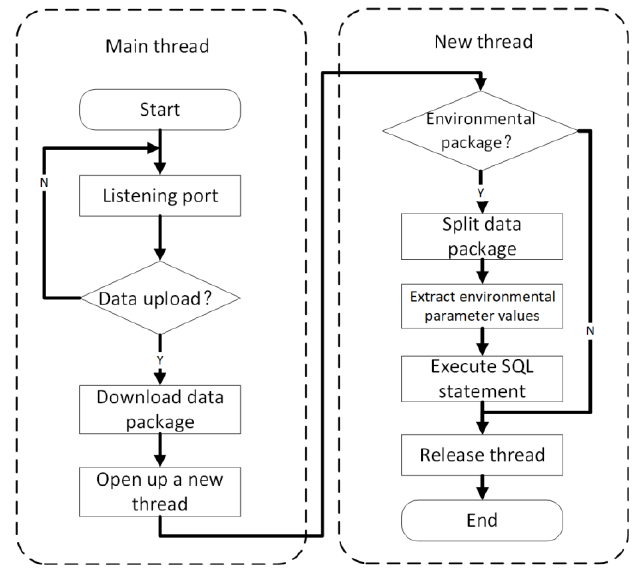
Figure 6. Data flow diagram of environmental information sensing unit.